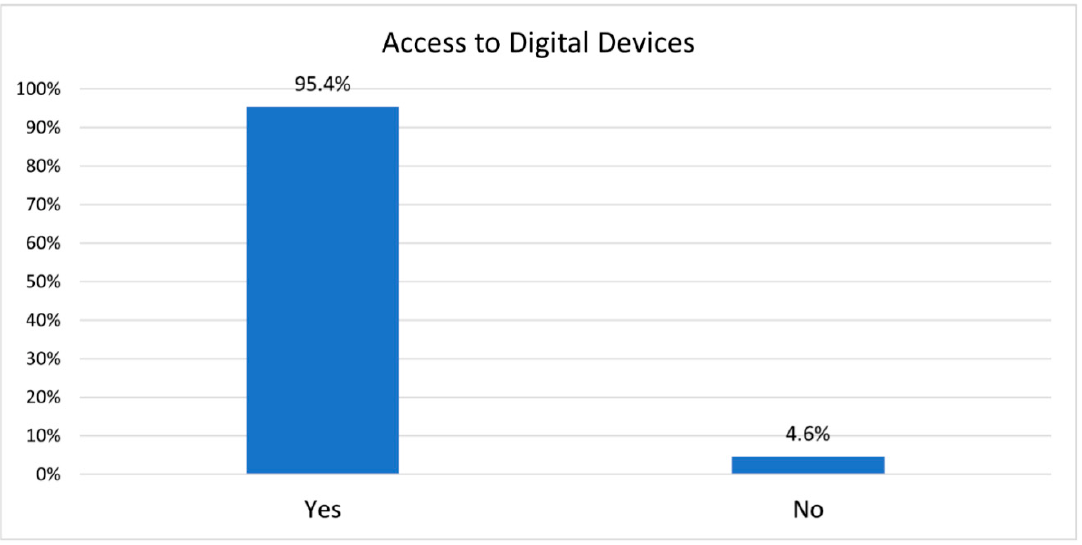
Figure 2. Participants’ access to digital devices.